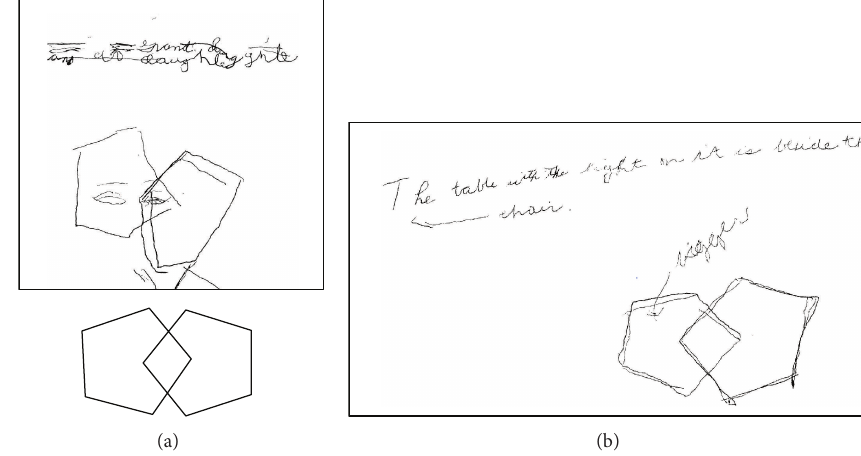
Figure 1: Writing/drawing samples from patient. A writing sample and attempt at copying the Folstein MMSE intersecting pentagon figure. The left panel shows an attempt at both in the absence of medication. The right panel shows subsequent improvement when taking zolpidem CR. The original figure from the Folstein document is reproduced above.